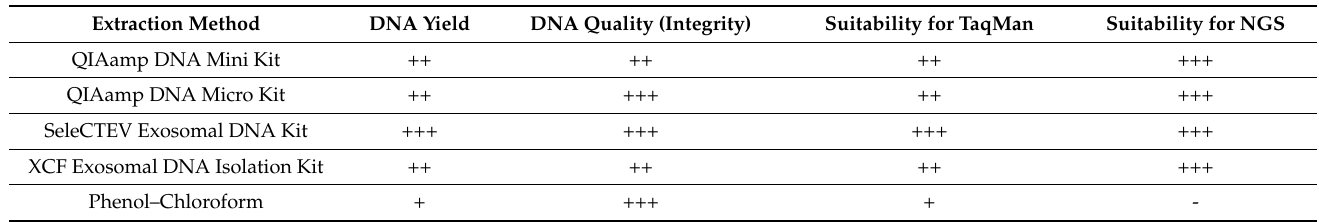
Table 6. Strategic points for EV-DNA extraction and quality control for mutational analyses. Extraction Method DNA Yield DNA Quality (Integrity) Suitability for TaqMan Suitability for